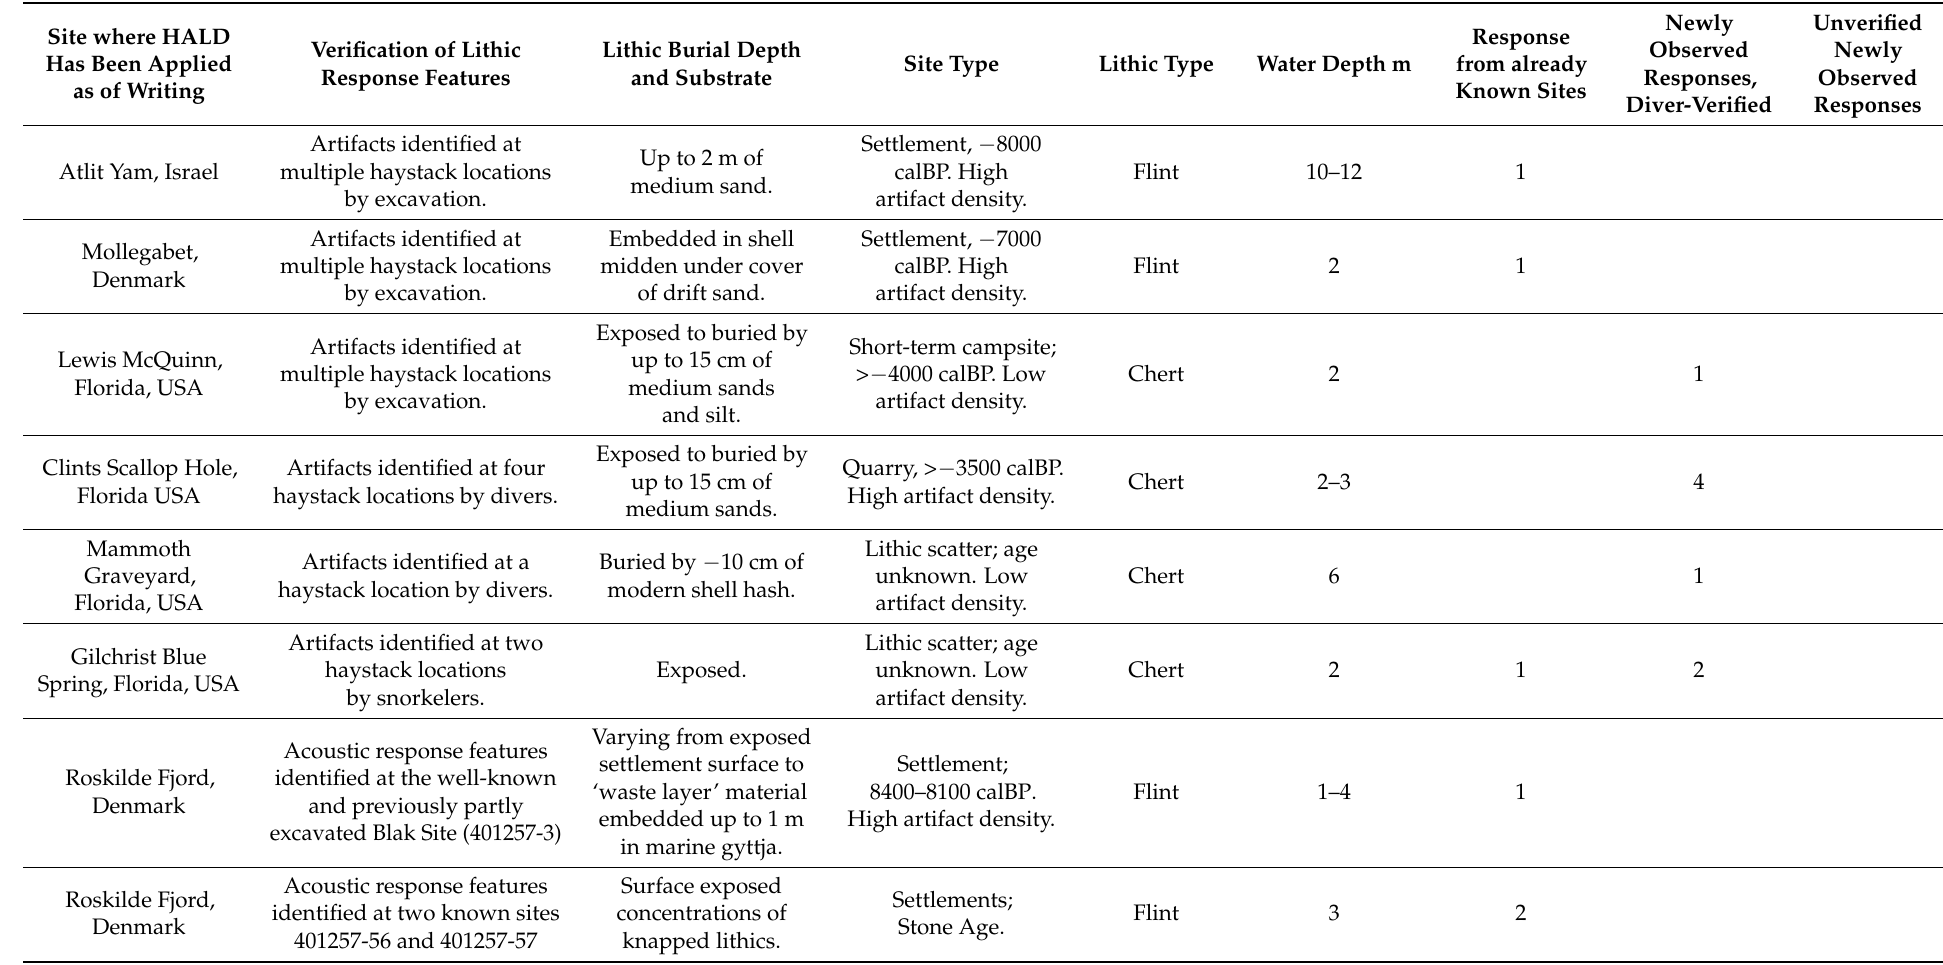
Table 2. Summary of key attributes of sites mentioned in text which have been subjected to HALD